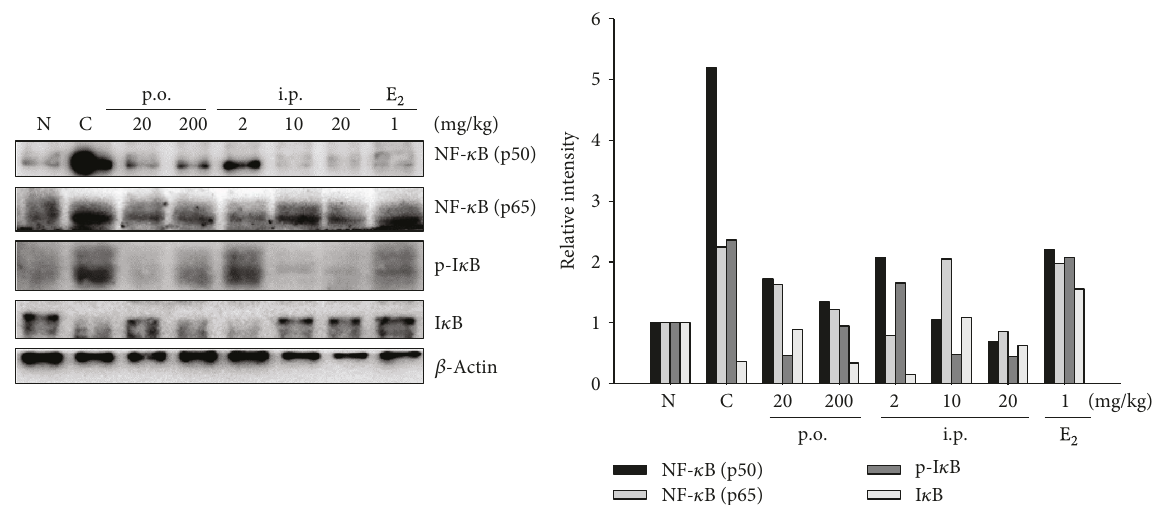
Figure 5: E ff ects of SHINBARO on the protein levels of NF- κ B and I κ B- α in the LSS rat model. β -Actin was used as an internal control. Relative intensity of indicated proteins was semiquanti fi ed using the NIH ImageJ